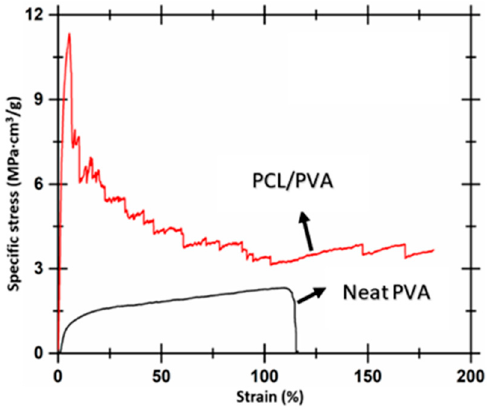
Figure 6. Representative specific stress versus strain curves recorded for neat PVA and PVA reinforced with PCL fibers.